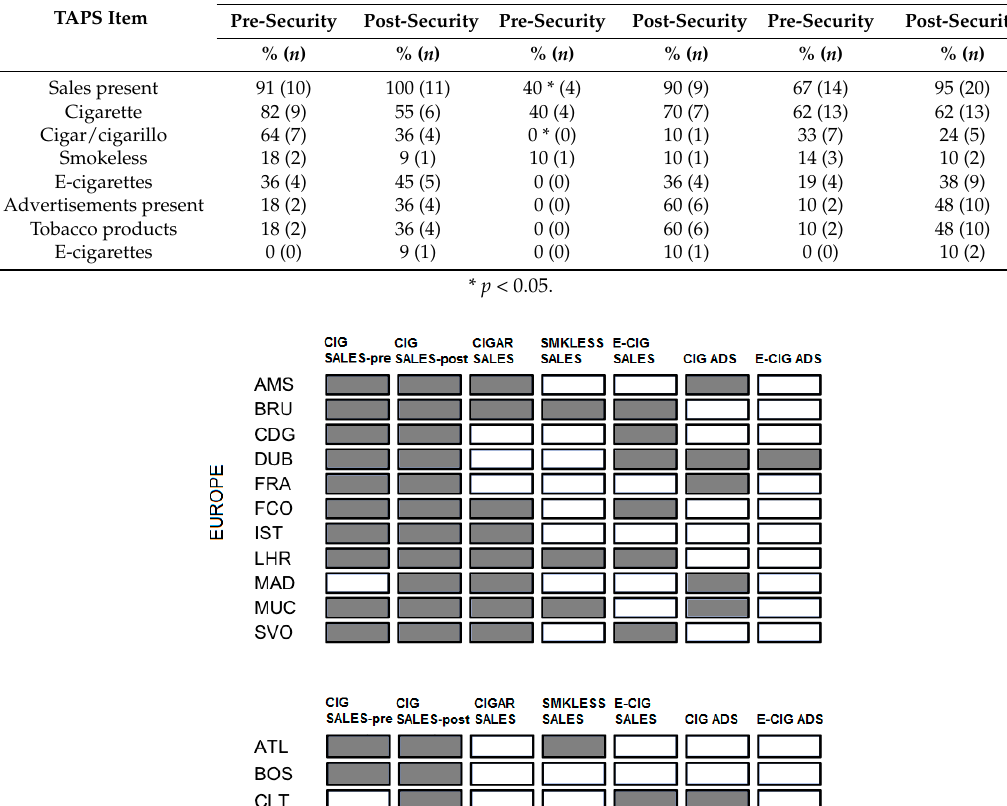
Table 1. Presence of TAPS observed in airports in Europe and the US, by location, 2014.